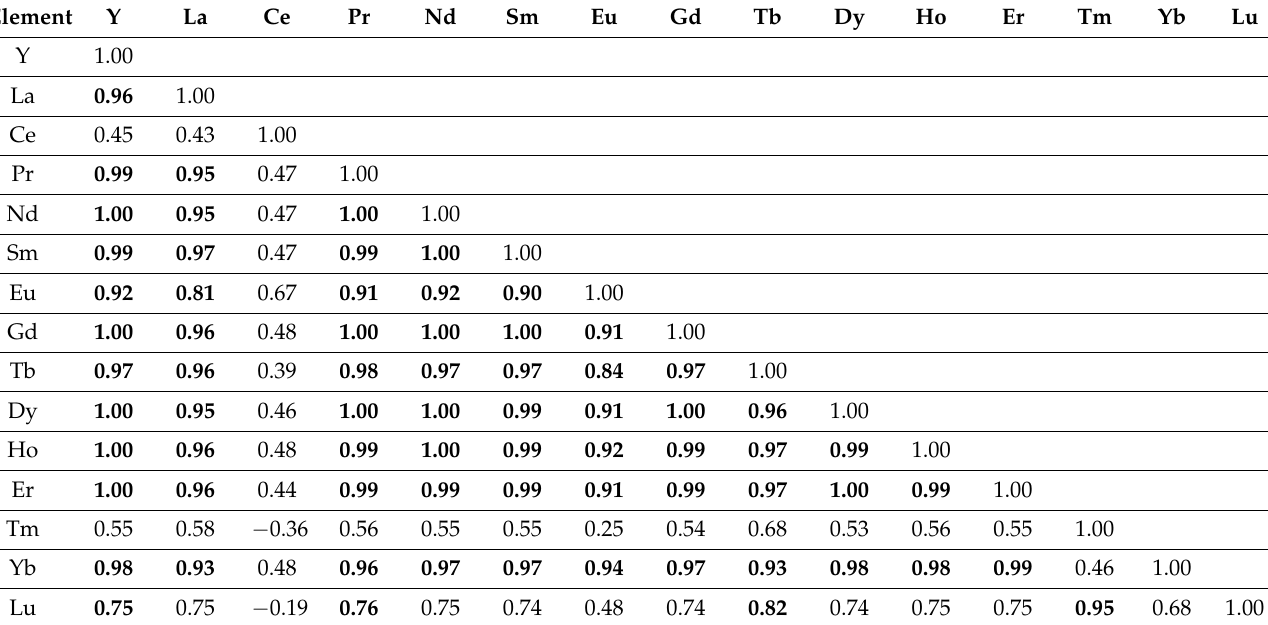
Table 10. Correlation between rare earth